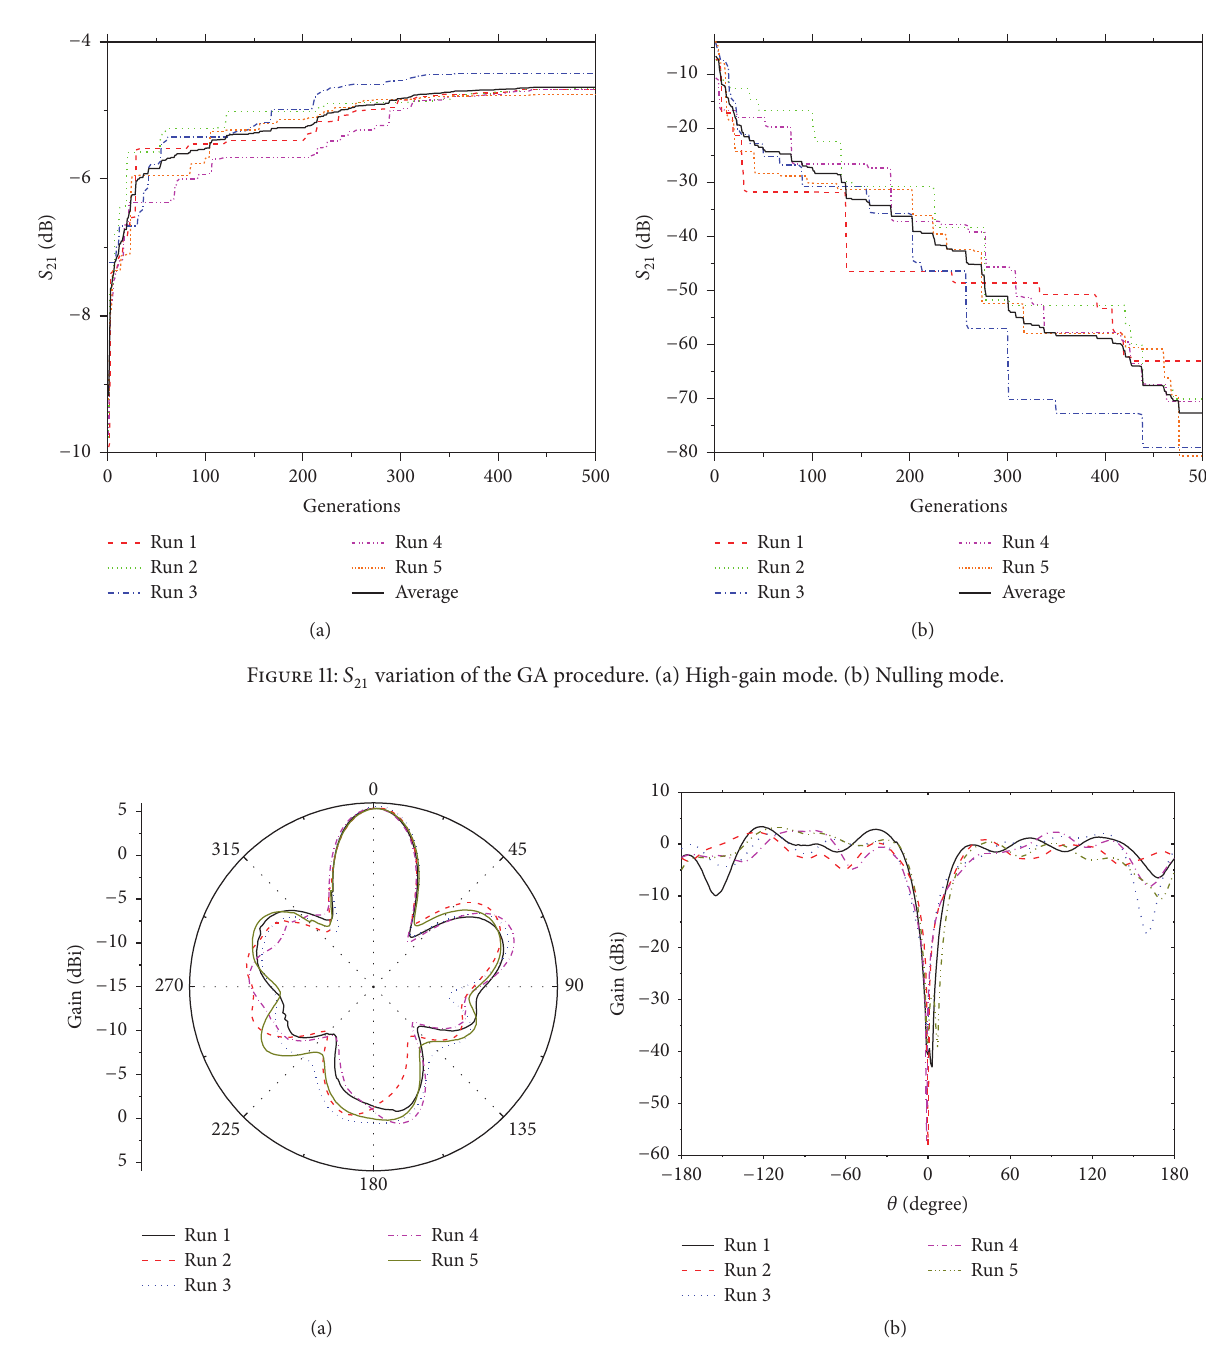
optimize the high-gain mode at 2.45 GHz. The best 𝑆 21 of each